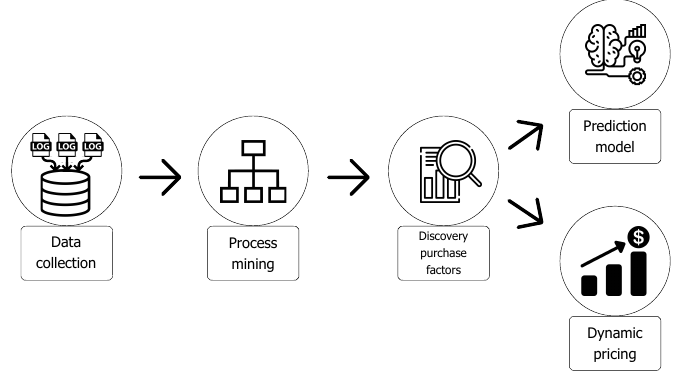
Figure 1. The steps of the DA4PT